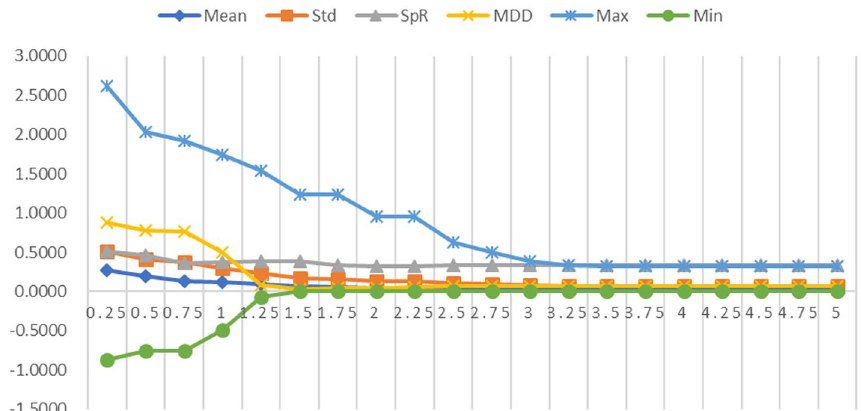
Fig. 8 The relation between the risk preference φ and out-of-sample performance. Note: This figure plots the impact of the change of investor’s risk preference φ on the model (10). The x-axis is the parameter φ and the value interval is 0.25. There are 20 groups of data in total. The y-axis is the value corresponding to different